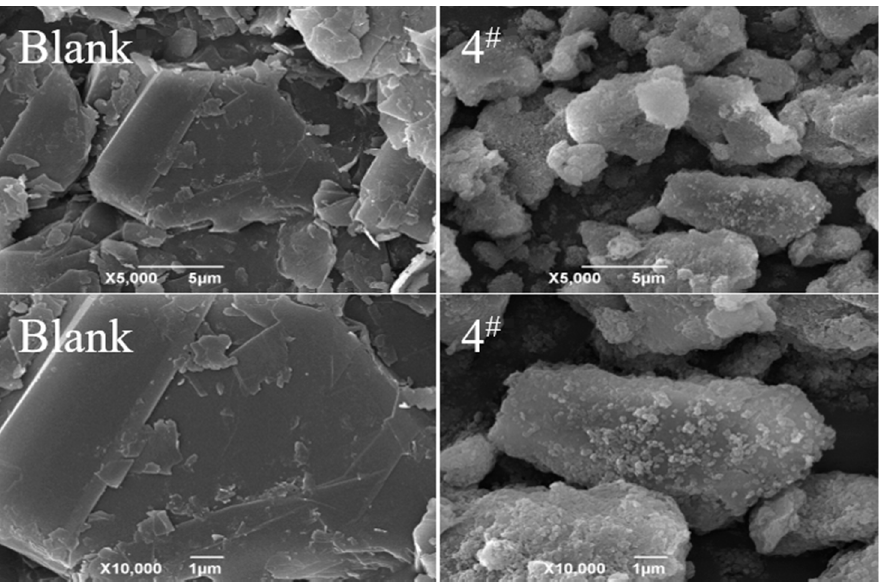
Figure 5. SEM image of the graphite surface before (above) and after (below) modification with CTAC.